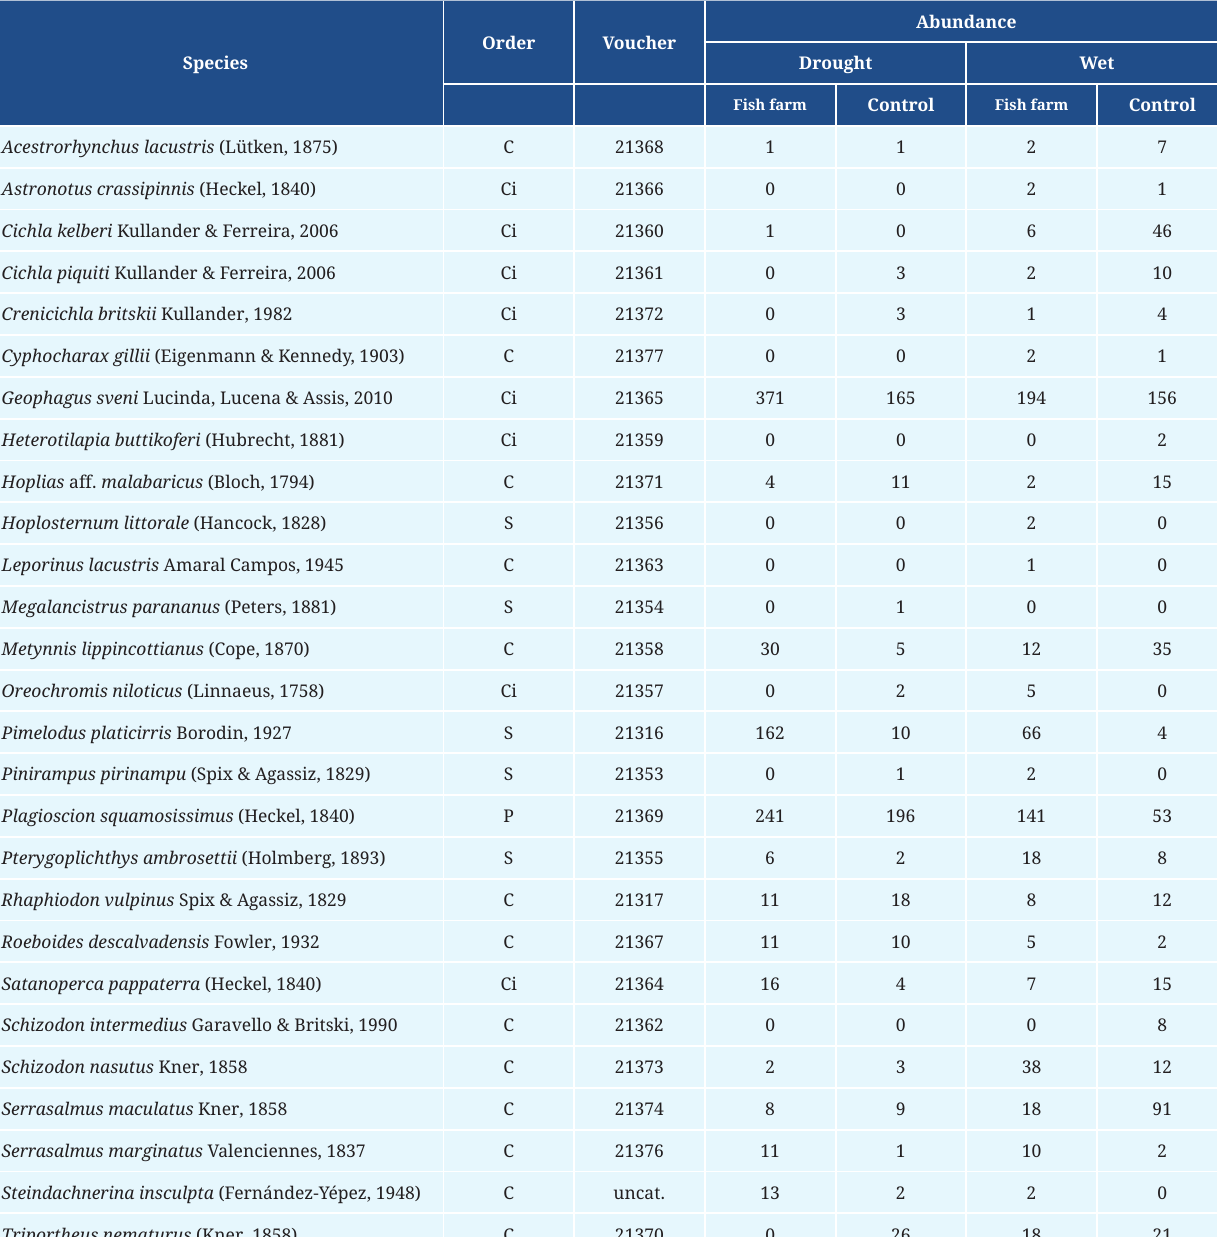
TABLE 1 | Taxonomic order of the sampled species and their abundance during the drought and wet seasons in the control area and fish farm area at the Ilha Solteira reservoir, Upper Paraná River, SP, Brazil. C = Characiformes, P = Perciformes, Ci = Cichliformes, and S = Siluriformes. Voucher specimens of